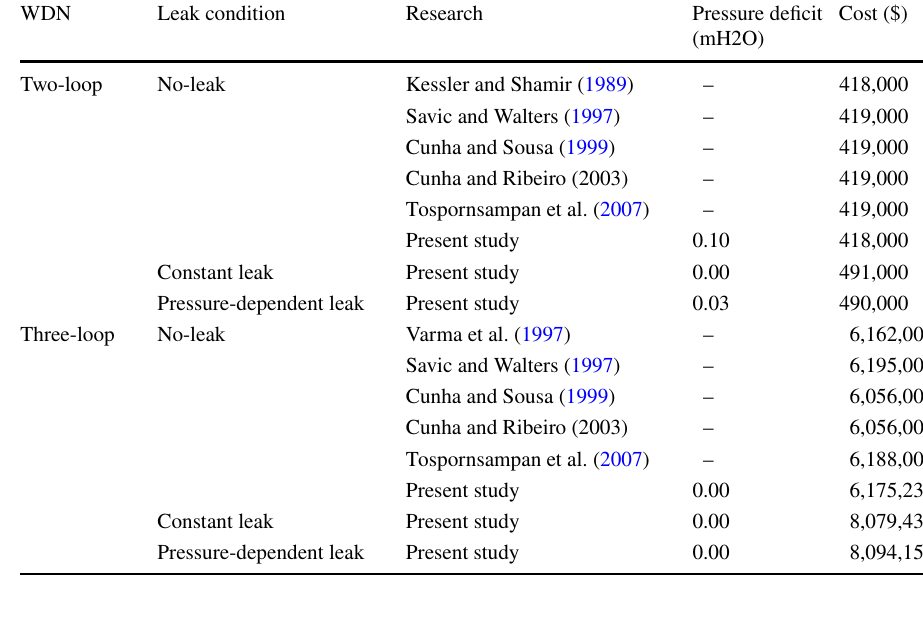
characteristics of NSGA-II and GA for top answer of two- and three-loop